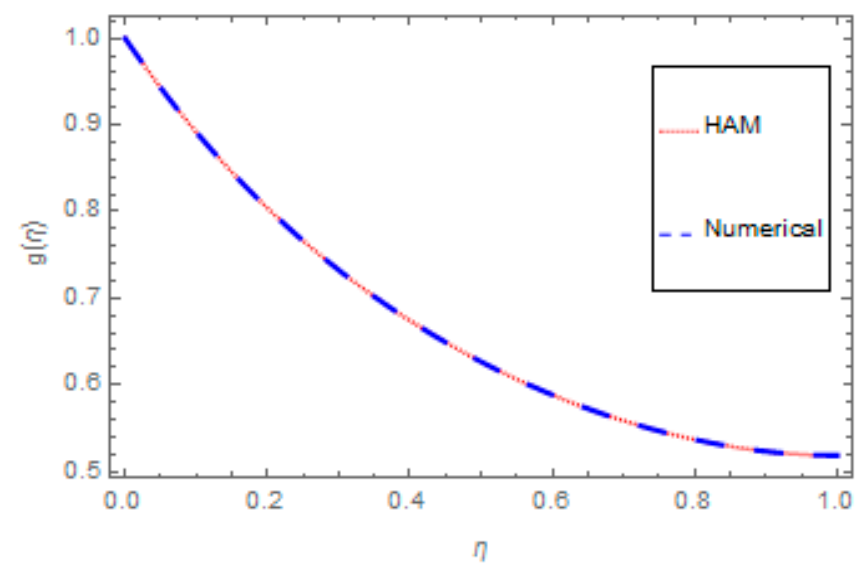
Figure 3. Comparison of the HAM and ND-Solve technique for velocity function g ( η ) .